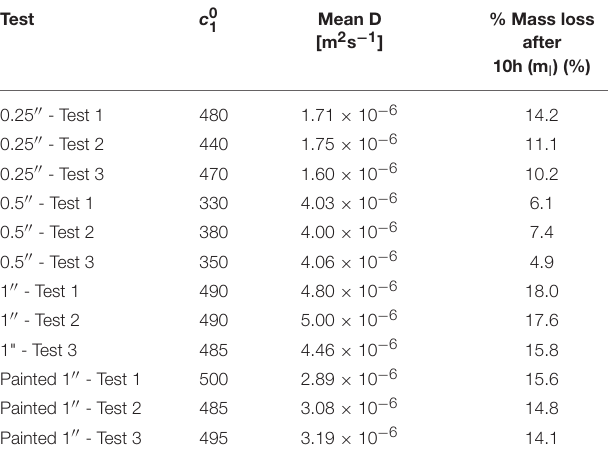
FIGURE 3 | Mass loss rate comparison for 0.5 ′′ test 2. c 1 0 is compared to c 1 ( t ) + c 2 ( t ) over 10h.